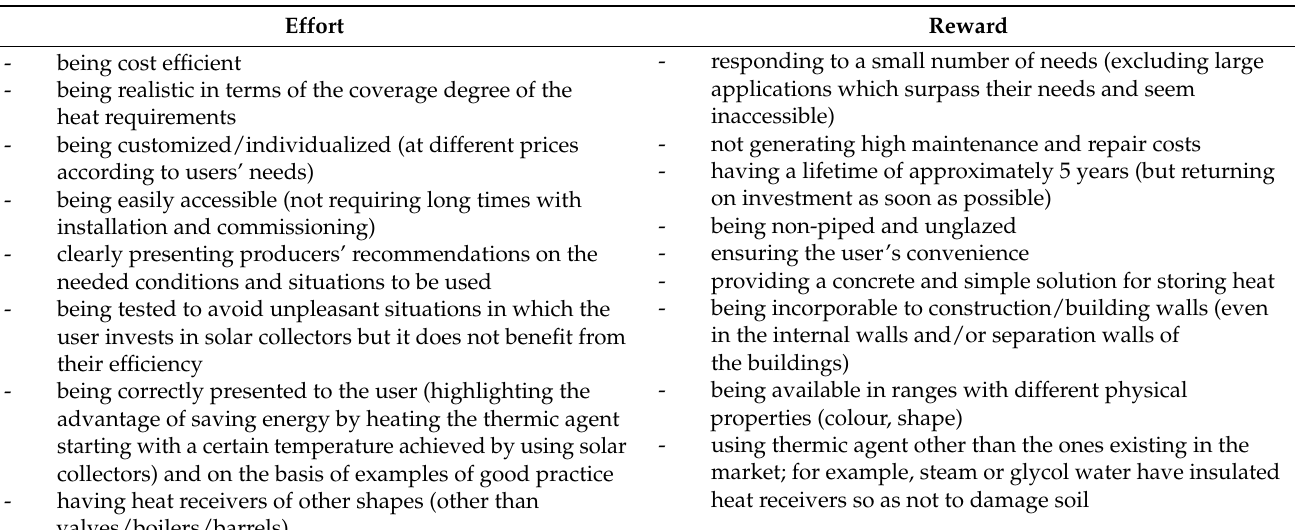
Table 3. Predictors of effort and reward in acquiring an application integrating solar thermal